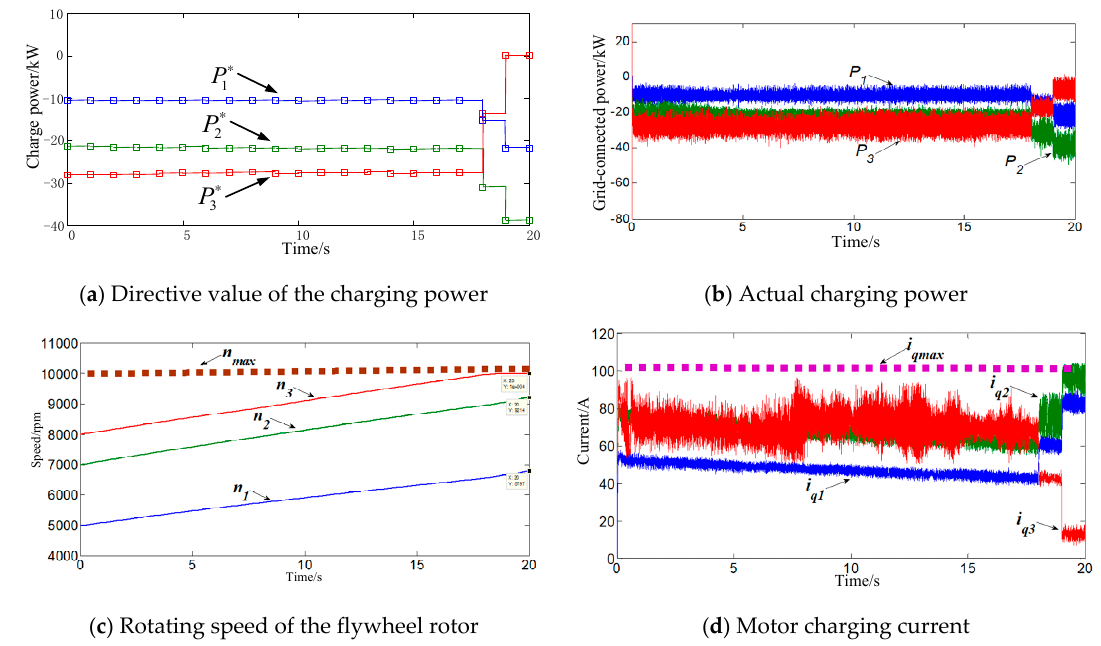
Figure 17. Simulation waveforms of power charging distributed by the EIP.